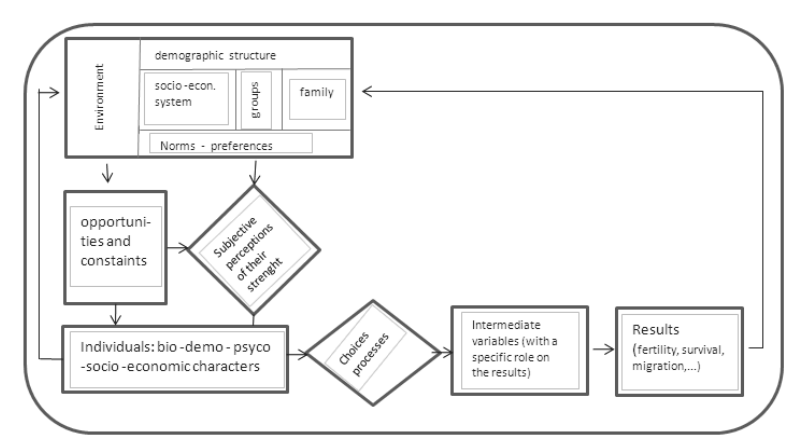
Figure 2 – A reference framework to study demographic processes (source: De Sandre,